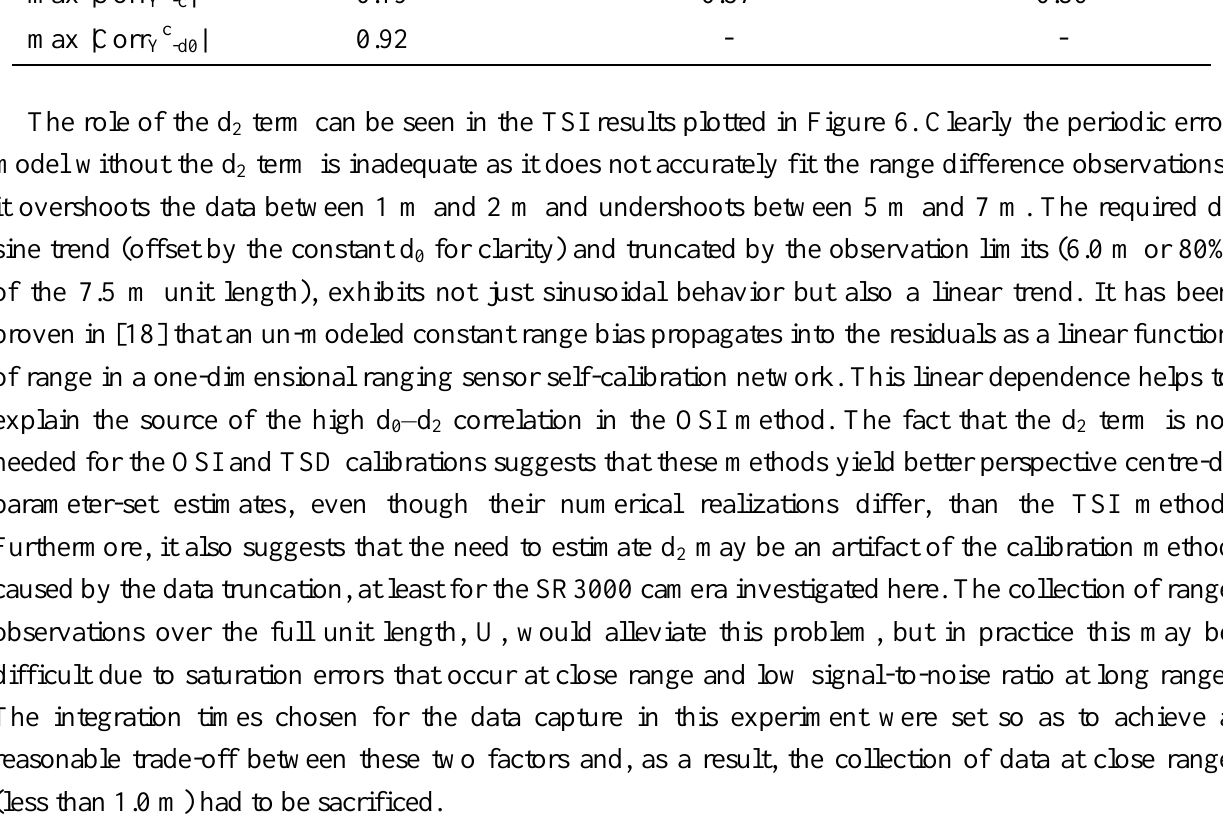
Table 5. Selected SR3000 adjustment results with and without the d